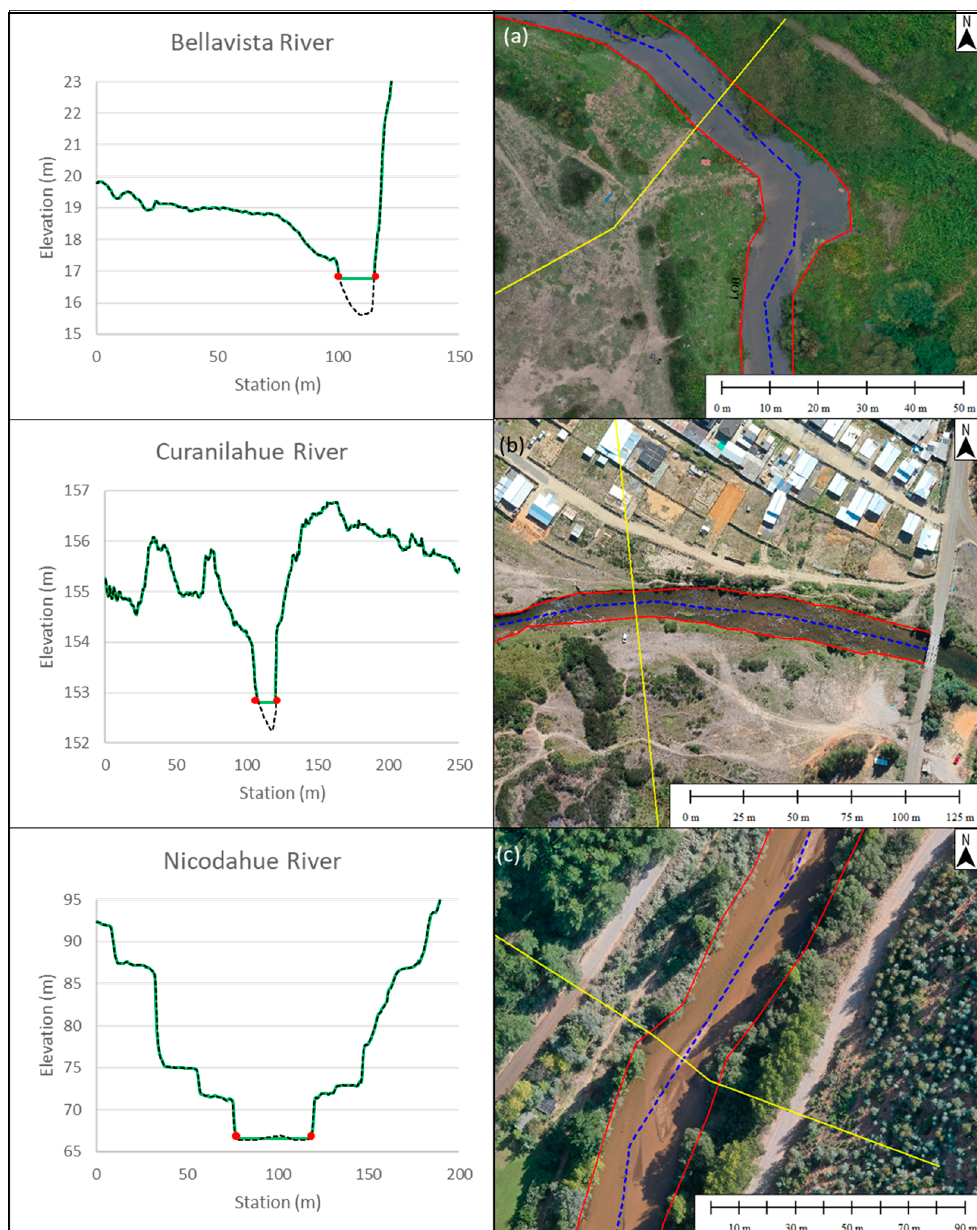
Figure 2. Cross sections of the ( a ) Bellavista (Lat/Lon: 37°29 ′ 34 ″ S, 73°19 ′ 27 ″ W), ( b ) Curanilahue (Lat/Lon: 37°29 ′ 34 ″ S, 73°19 ′ 27 ″ W), and ( c ) Nicodahue (Lat/Lon: 37°29 ′ 04 ″ S, 72°46 ′ 21 ″ W) rivers. The solid line shows the flat bed assumed using the DTM-RS, while the dotted line is from the DTM-T. The right panels show an aerial view of the river, while the left panels show the cross section (yellow line) derived for the DTM-RS and DTM-T. The red lines indicate the banks.